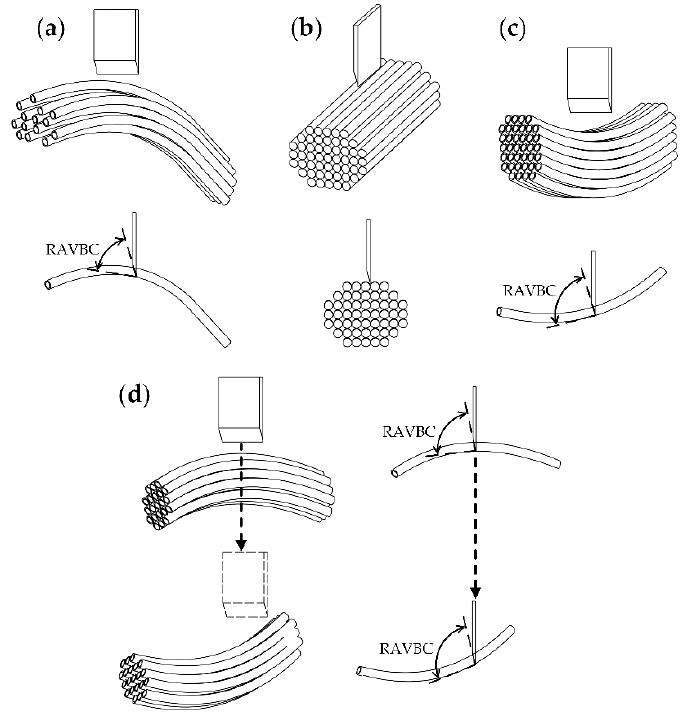
Figure 9. Schematic diagram of cutting vascular bundles at different positions. The vascular bundle is represented by a tubular structure in the figure, and the cutter is located above the vascular bundle. ( a ) Represents positions 1–3 in CSCTR, respectively; ( b ) are positions 4–6 in CER, respectively; ( c ) includes position 7 in CER and position 8 in CFTR; ( d ) illustrates position 9 in CFTR. In ( b ), it is difficult to mark “RAVBC” due to the extremely small relative angles. RAVBC = Relative angle between the vascular bundle and cutter.